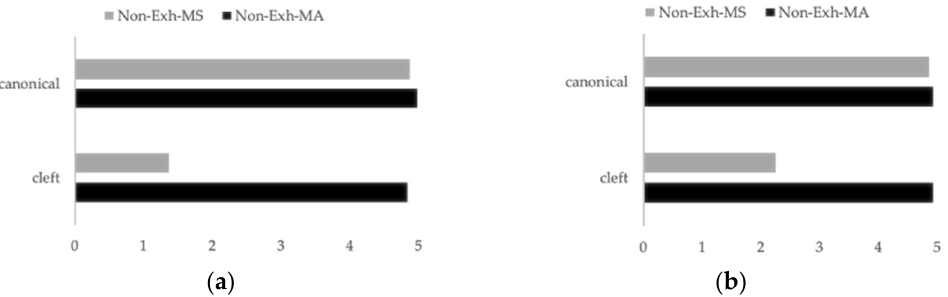
Figure 5. Average ratings for clefted and in-situ questions in the non-exhaustive picture condition, per Answer type: ( a ) Native speakers; ( b ) L2 learners.